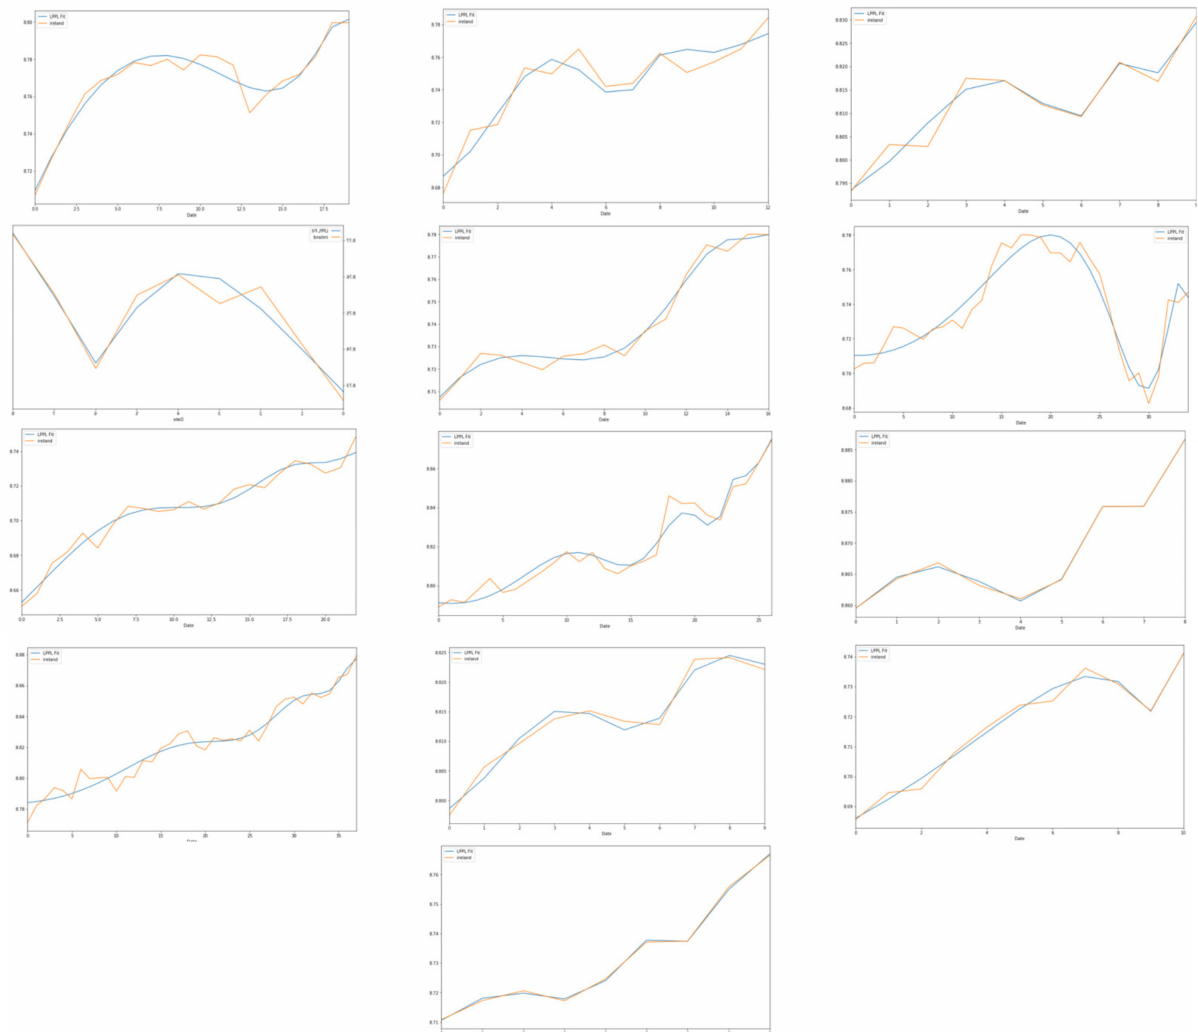
Figure A1. LPPL Signatures in the Irish Stock Exchange (ISEQ) 15 January 2015 to 14 January 2020. Log-periodic power law signatures in the Irish Stock Exchange.